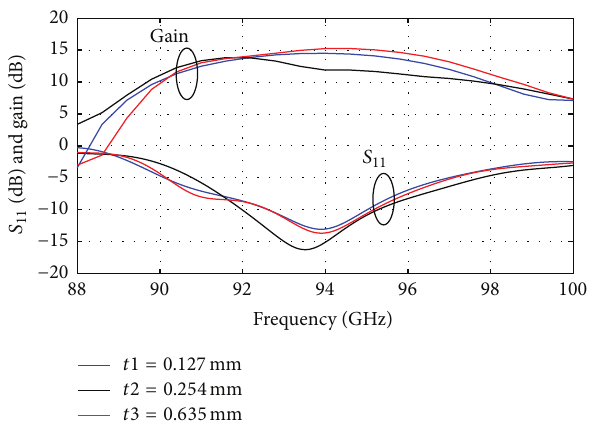
Figure 8: Simulated results of 𝑆 11 and gain with various superstrate thickness for a fixed height ℎ = 0.55𝜆 0 , and size of the superstrate 𝑆 = 3.125 × 3.125𝜆 0 .